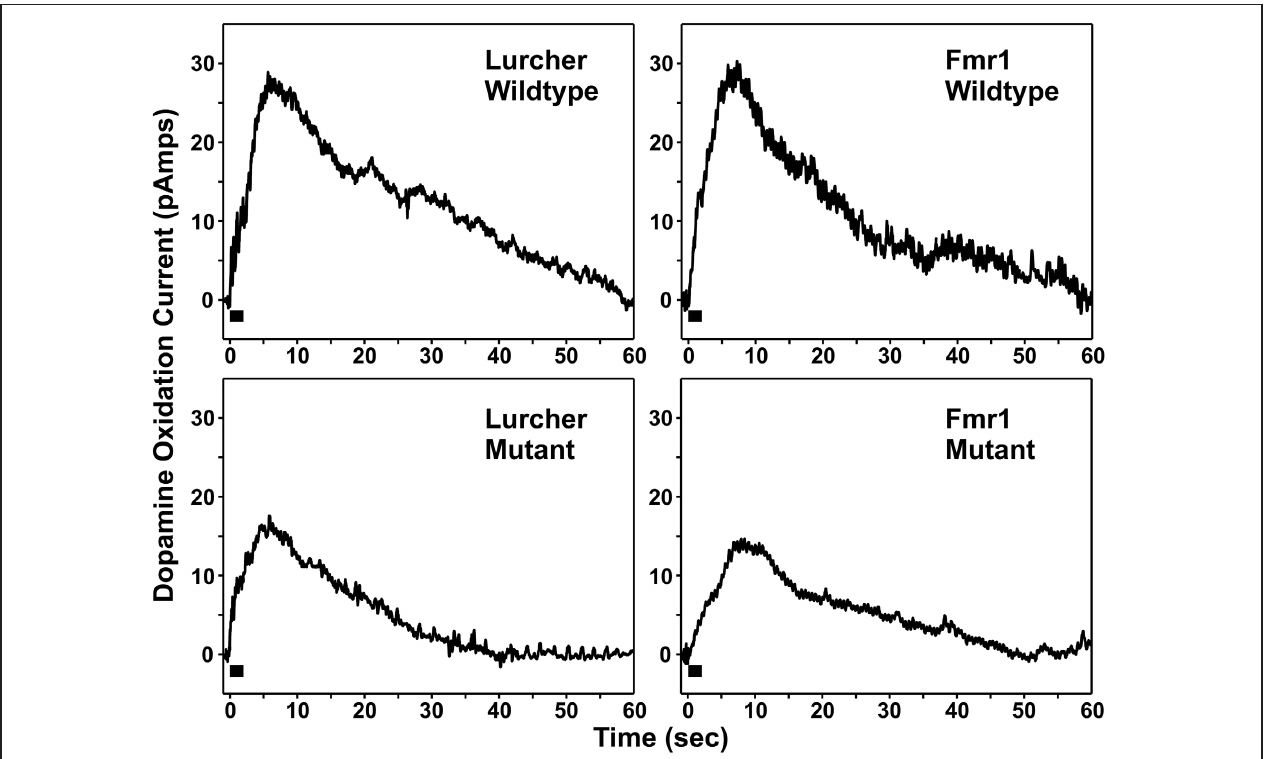
FIGURE 2 | Individual examples of medial prefrontal cortex dopamine release responses evoked by electrical stimulation (black bar, 100 pulses at 50Hz) of the dentate nucleus.